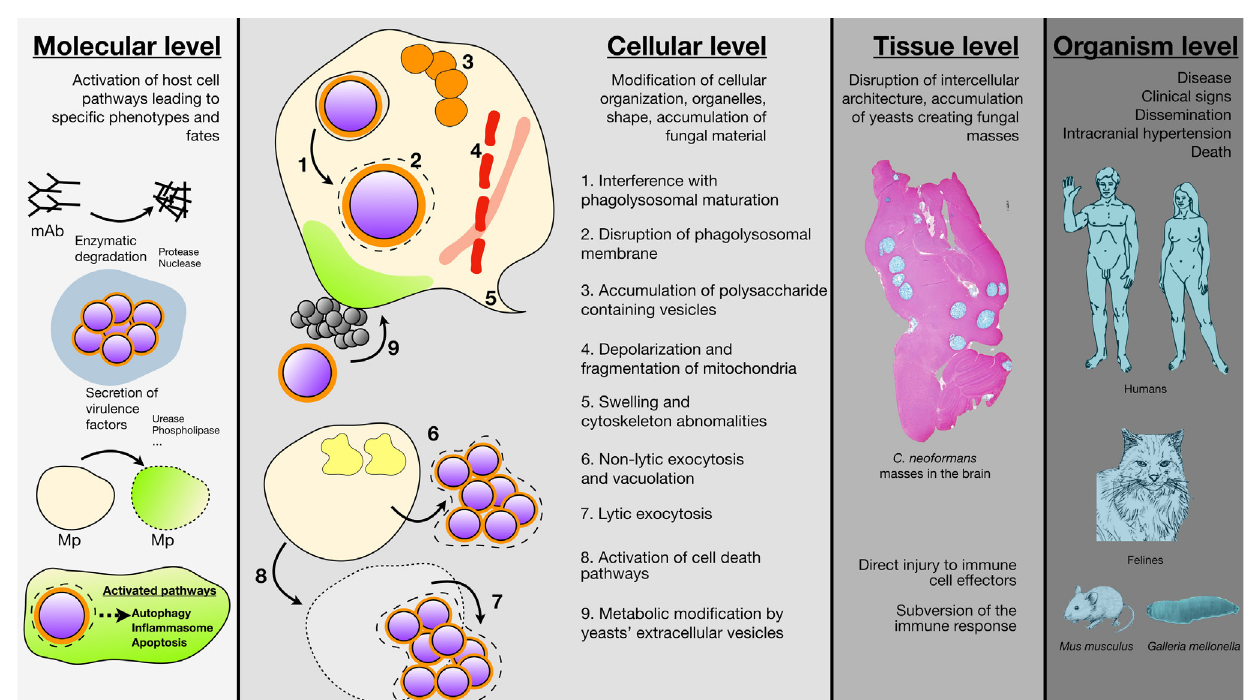
FiguRe 1 | Schematic representation of the different Cryptococcus neoformans -mediated cell host damages are various scales. Damage at the molecular level results from the secretion of various enzyme by C. neoformans (proteases, nuclease, urease, phospholipase) that degrade host molecules such as antibodies and/or modify cells membranes. C. neoformans ingestion is also able to trigger autophagy, apoptosis, and cell death in the host (mAb, monoclonal antibodies; Mp, macrophages). Damage at the cellular level involves modification of cellular compartments such as accumulation of polysaccharide vacuoles (1), inhibition of phagolysosomal maturation (2), phagolysosomal leakage (3), mitochondrial fission and depolarization (4), swelling and cytoskeleton abonomalities (5) or metabolic modification due to C. neoformans vesicles secretions (6), C. neoformans engulfment resulted also in non-lytic (7), or lytic (8) exocytosis. Damage at the tissue level consisted typical cryptococcal lesions in the brain parenchyma after intravenous inoculation of C. neoformans to outbred mice (sacrifice seven days after inoculation). No granuloma and accumulation of yeast masses without inflammatory cells can be observed engendering tissue disorganization. Coloration Alcian Blue (magnification 4 × ). Damage at the organism level combines to produce the clinical signs associated with cryptococcal diseases in humans with dissemination and neurological abnormalities as the most severe clinical presentation leading to death. Felines are also naturally susceptible to cryptococcosis with localized to disseminate infections. Mus musculus and Galleria mellonella are well established organisms for experimental models of infection that help understanding the pathophysiology of the disease and the biology of the yeast in relation to the host.